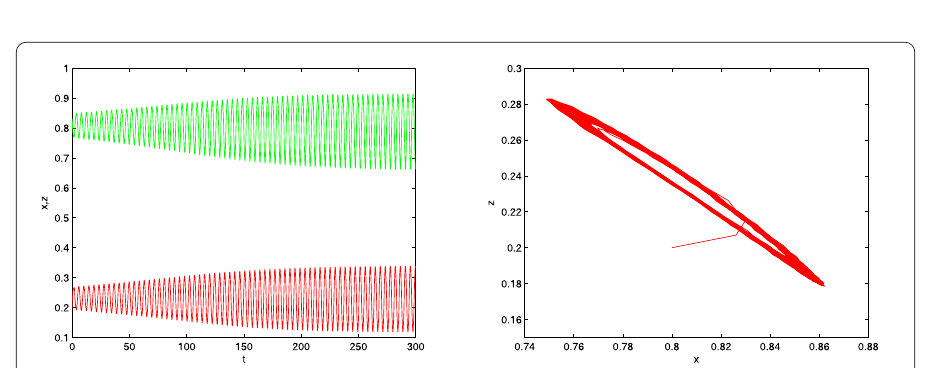
Figure 3 The system is asymptotically stable around the equilibrium point for ( μ 1 , μ 2 ) = (–0.17,–0.10). The green line represents x , the red line represents z . Waveform diagram for variable of x , z (left). Phase diagram for variable ( x , z ) (right)